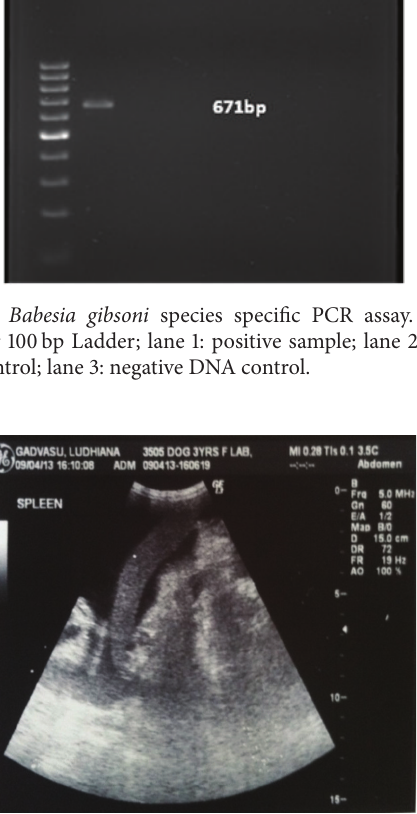
Figure 3: USG of abdomen showing anechoic area indicating free flowing fluid in abdomen.